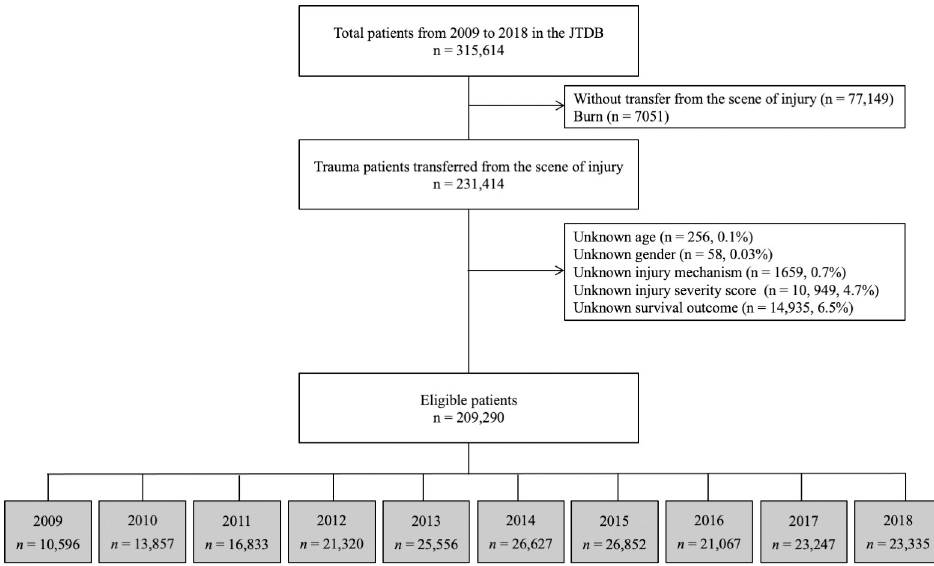
Fig 1. Flow diagram of the study patient selection for this